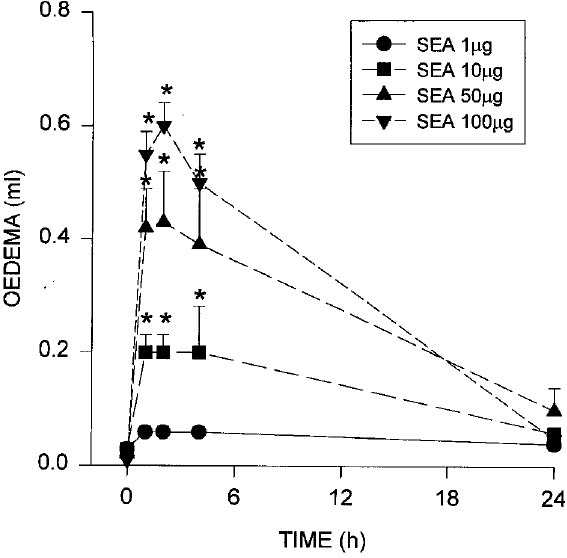
FIG. 3. Dose–response (oedema) curve induced by admin- istration of S. mansoni Soluble Egg Antigen (SEA) in rat paws. Various doses (1, 10, 50 and 100 m g/site) of the antigen were diluted in 0.1ml physiological saline and injected intraplantarly in rat hindpaws. Measurements were obtained in a hydroplethysmother (Ugo Basile) at zero, 15, 30, 60, 120, 240min and 24h following administration of the antigen ( n =6–15). Statistical significance is indicated by * P <0.05 (Anova t -test).